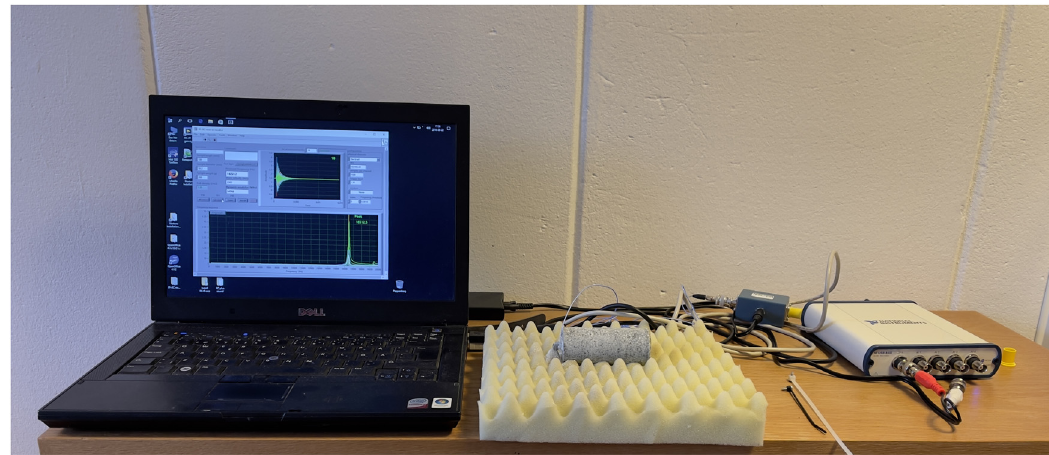
Figure 2: A process of seismic measurements which evaluates P - wave velocity of the specimen. Photo source: Per